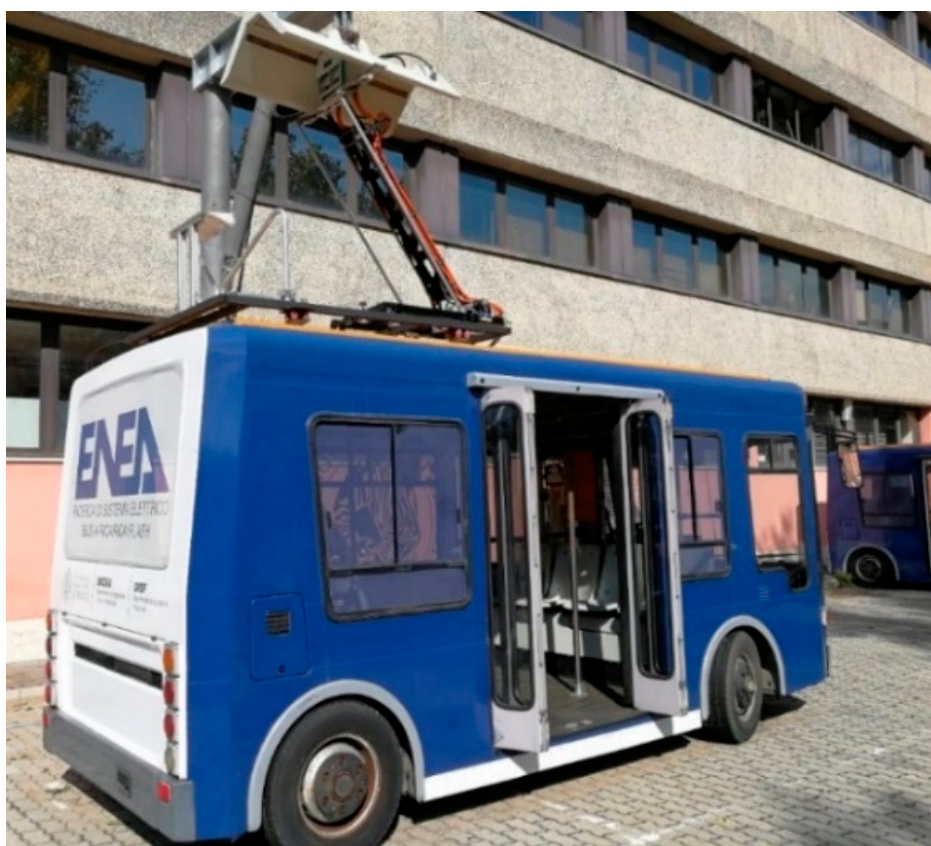
Figure 1. Electric bus, part of the experimental test rig at ENEA Casaccia Research Center.